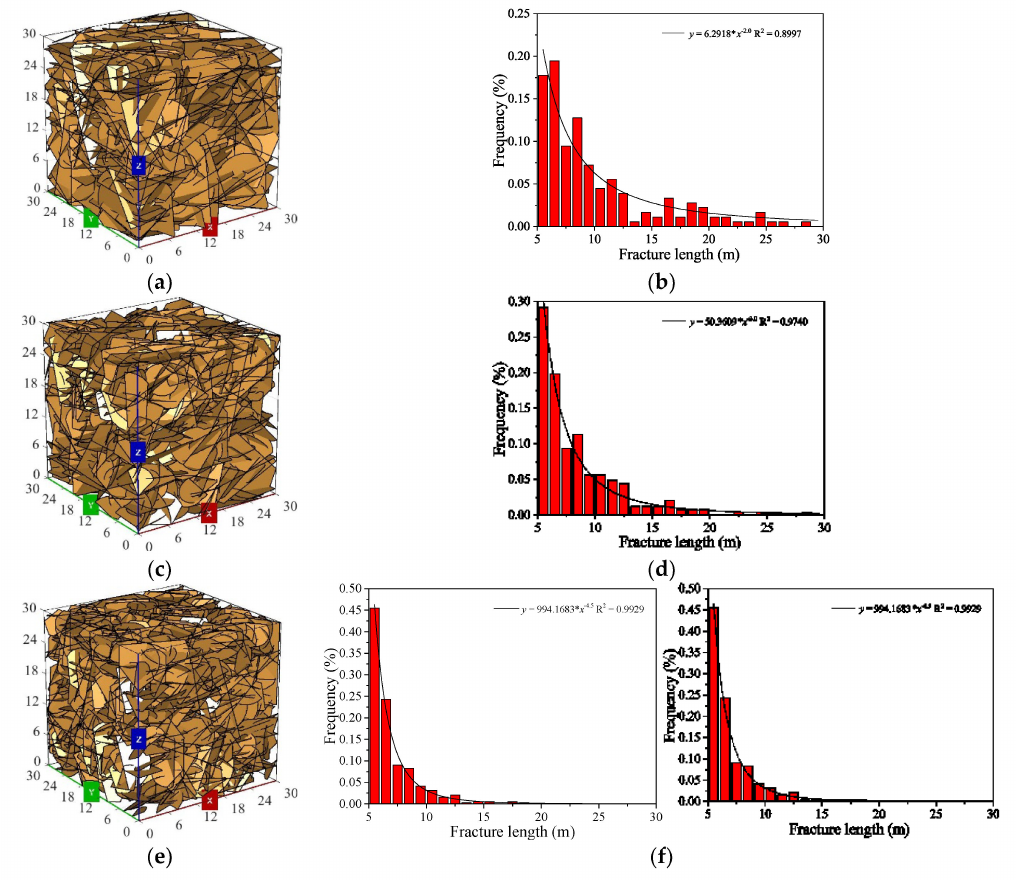
Figure 5. Three-dimension DFN models and corresponding statistical histograms of the fracture length with different a when P 32 = 0.4. ( a ) The DFN model when a = 2.0; ( b ) The distribution of fracture length when a = 2.0; ( c ) The DFN model when a = 3.0; ( d ) The distribution of fracture length when a = 3.0; ( e ) The DFN model when a = 4.5; ( f ) The distribution of fracture length when a =